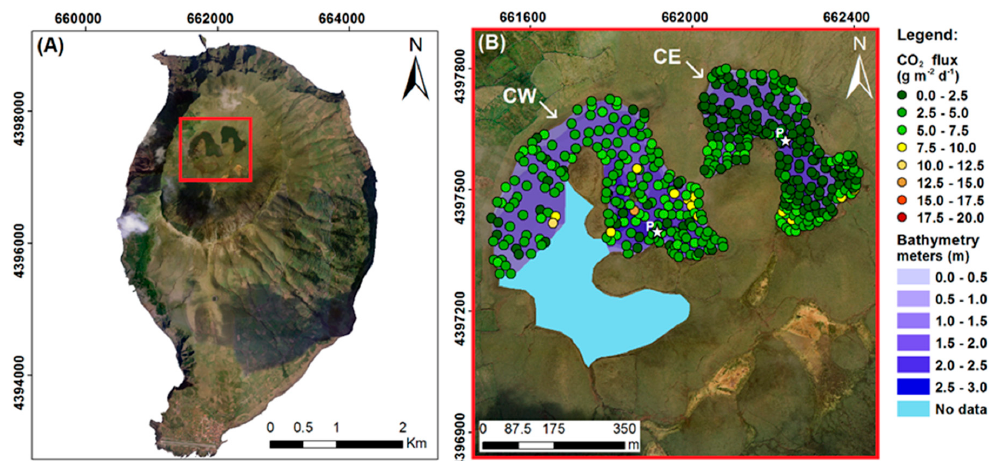
Figure 1. Location of the studied area (UTM–WGS1984, zone 25S): ( A ) framework of Corvo Island with the location of the studied lakes; ( B ) bathymetry and CO 2 flux sampling points measured in the first survey respectively for Caldeirão West (CW) and Caldeirão East (CE) lakes. The sampling locations of the geochemical vertical profiles (P) are also shown.